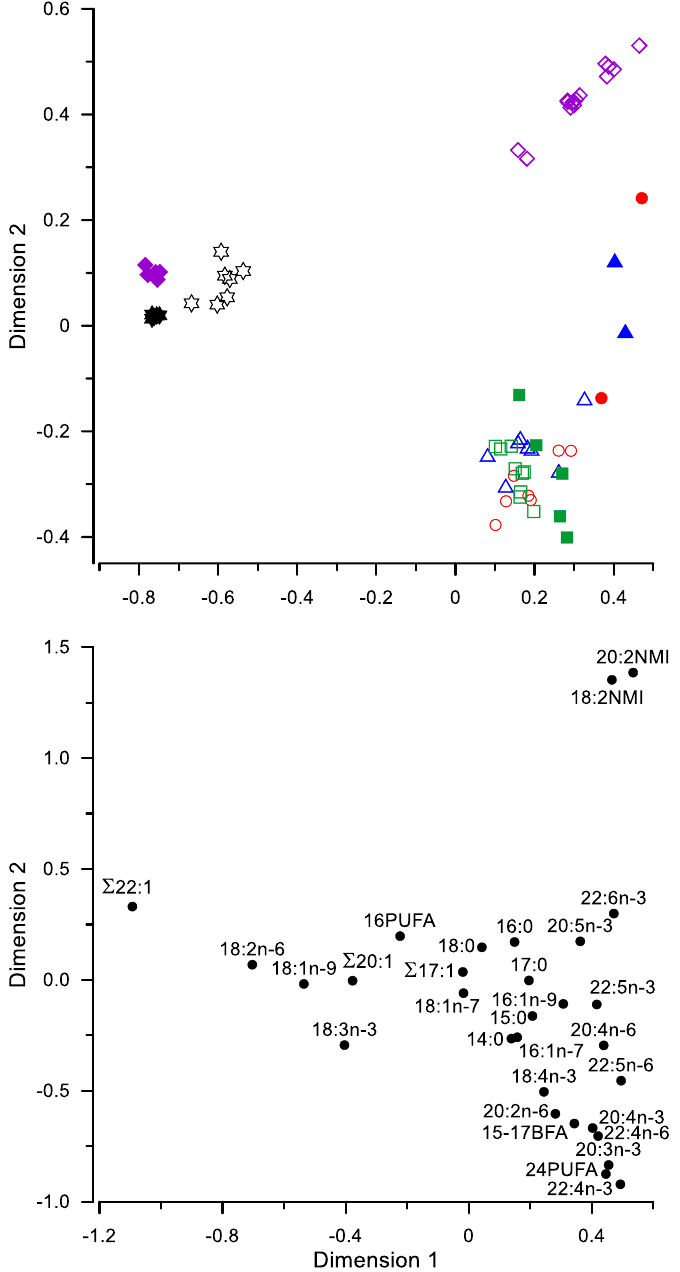
Figure 4. Canonical correspondence analysis of levels of fatty acids (% of the total) in fish species of genus Salvelinus (open symbols) and their food (closed symbols): circles—boganid charr S. boganidae ; triangles—goggle-eyed charr ( S. alpinus complex); squares—Dryagin’s char S. drjagini ; stars—Arctic charr S. alpinus from the Ropsha farm; diamonds—brook trout S. fontinalis from the aquaculture of Timiryazev Academy. Dimension 1 and Dimension 2 represented 58.4% and 26.8% of inertia, respectively.